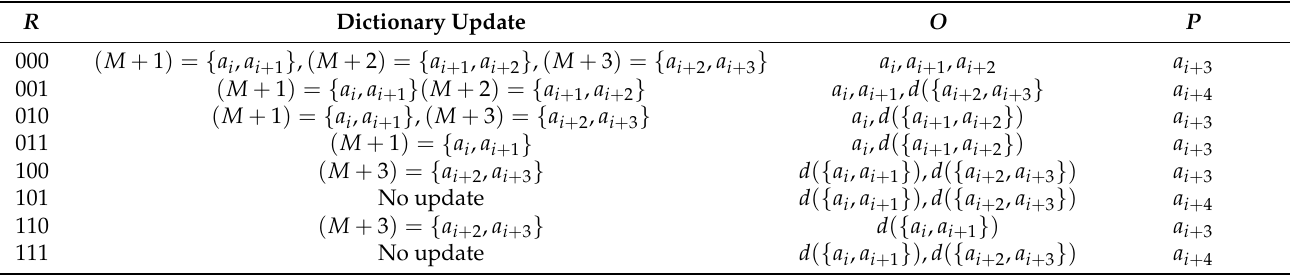
Table 2. Coding principle and dictionary update of the MCS-based LZW algorithm ( N = 3). R Dictionary Update O